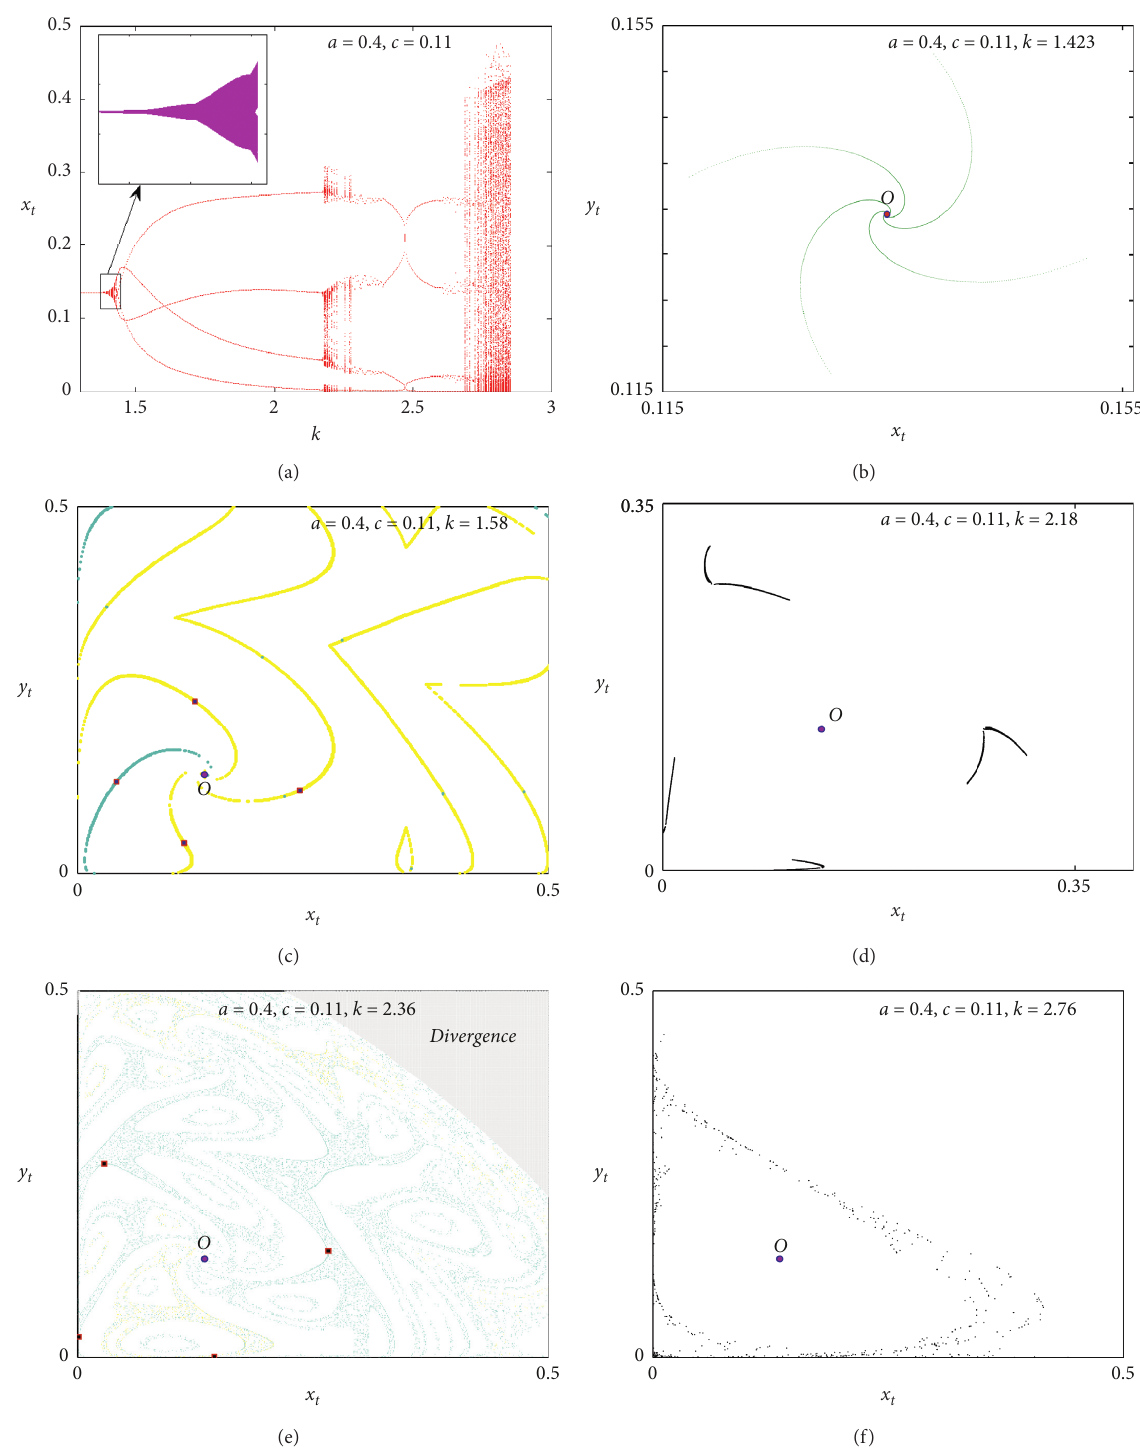
Figure 7: (a) The bifurcation diagram with respect to k at a � 0 . 4 ,c � 0 . 11. Different attracting sets. (b) A spiral at a � 0 . 4 ,c � 0 . 11, and k � 1 . 423. (c) Period-5 cycle at a � 0 . 4 ,c � 0 . 11, and k � 1 . 58. (d) Chaotic attractor at a � 0 . 4 ,c � 0 . 11, and k � 2 . 18. (e) Period-5 cycle at a � 0 . 4 ,c � 0 . 11, and k � 2 . 36. (f) Chaotic attractor at a � 0 . 4 , c � 0 . 11, and k � 2 .